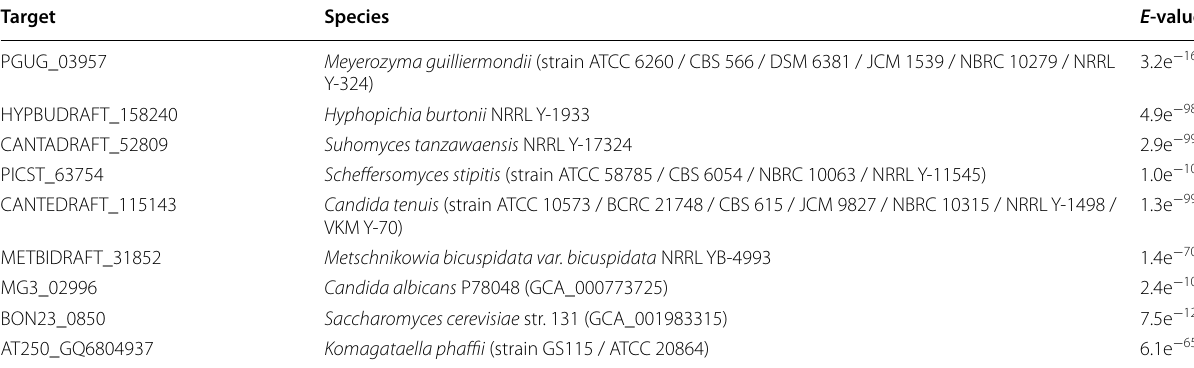
Table 2 HMM homologs hits on M. guilliermondii strain SO eukaryotic aspartyl protease